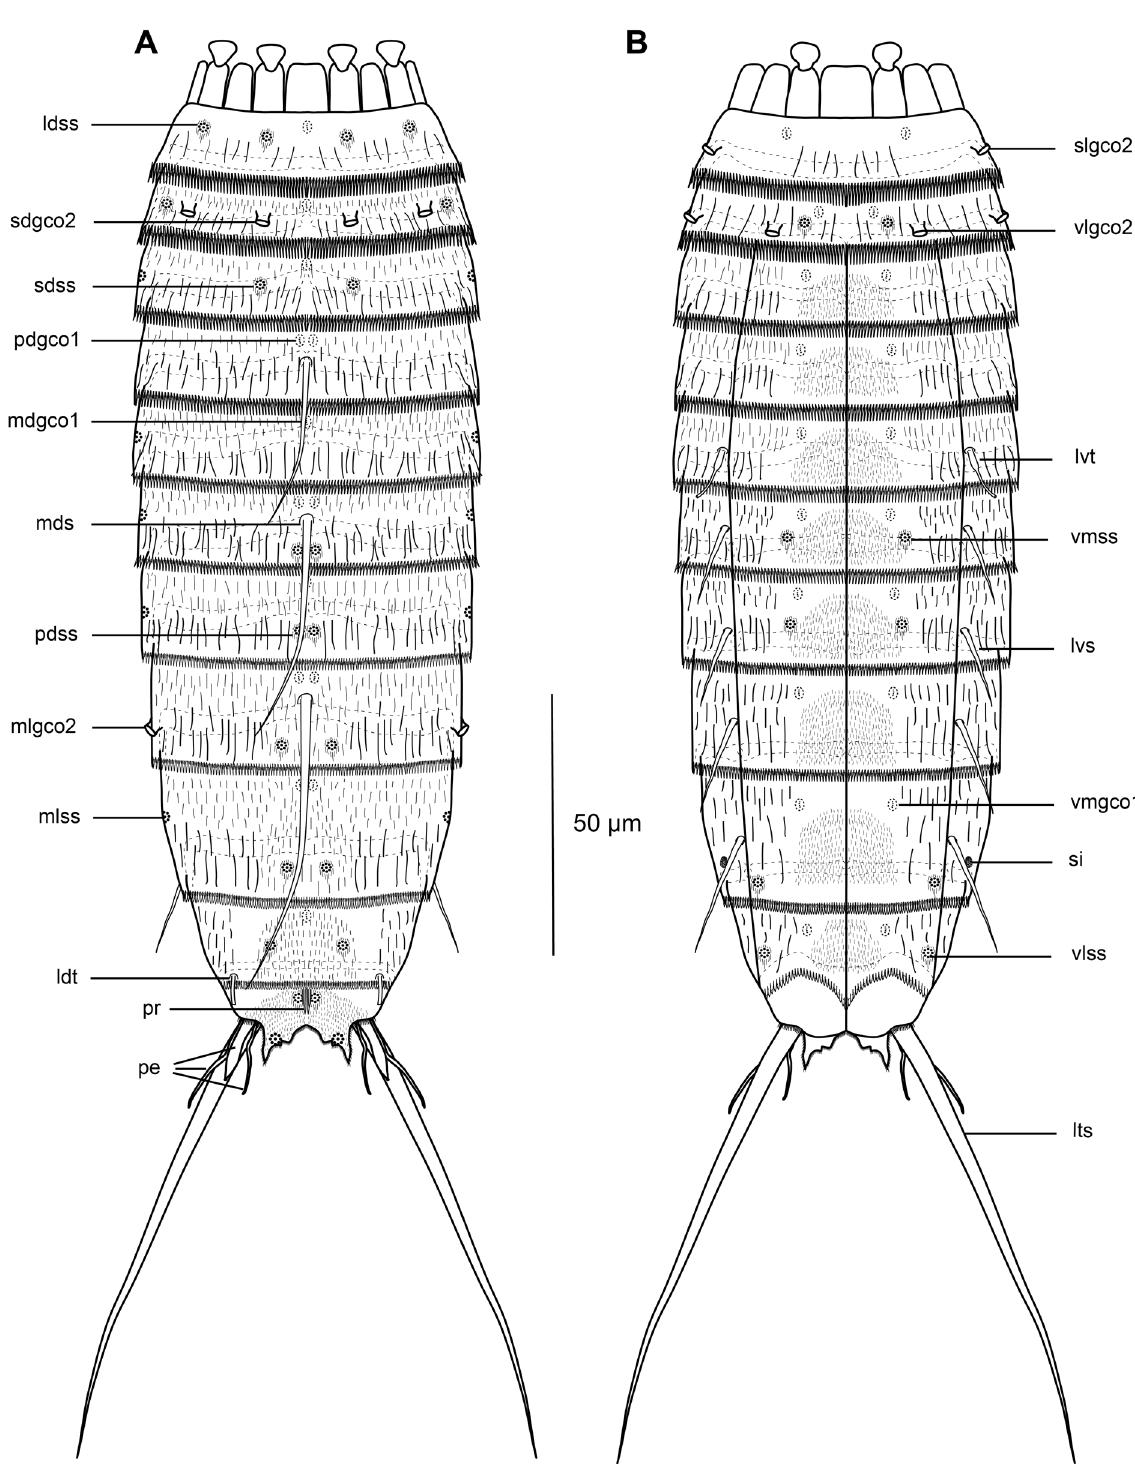
Fig. 23. Line art illustrations of Echinoderes legolasi sp. nov. A . ♂, dorsal view. B . ♂, ventral view. Abbreviations: see Material